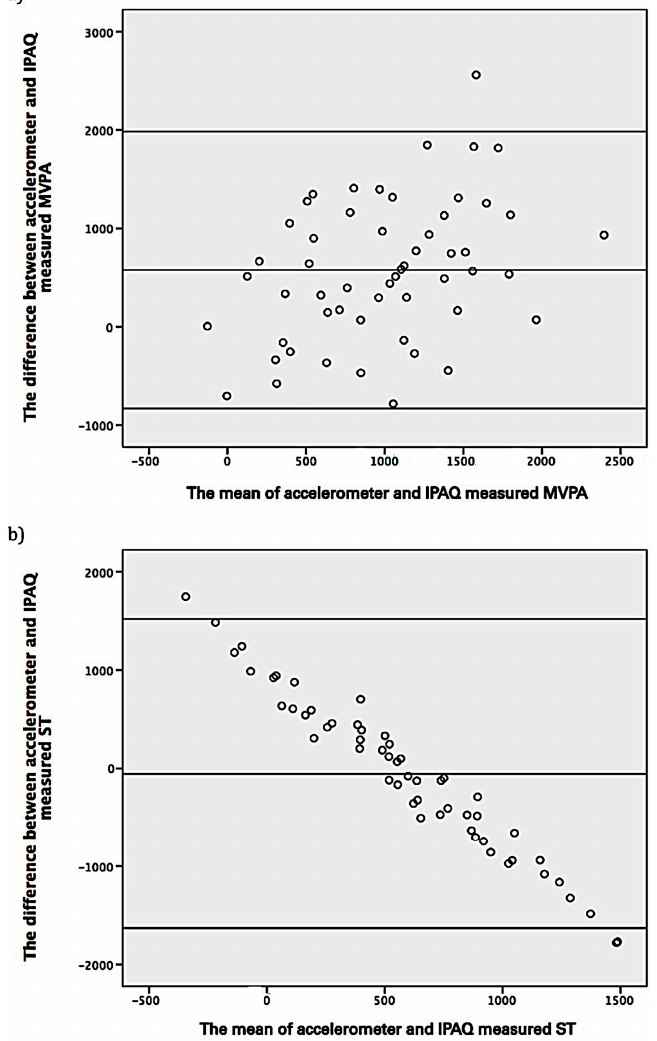
Figure 1. ( a ) The difference between accelerometer and IPAQ measured MVPA ( y -axis) plotted against the mean difference of accelerometer and IPAQ measured MVPA ( x -axis) with 95% limits of agreement. Overall mean difference was 578.2 MET–min/week and the limits of agreement were − 828.7 to 1985.1; ( b ) The difference between accelerometer and IPAQ measured ST ( y -axis) plotted against the mean difference of accelerometer and IPAQ measured ST ( x -axis) with 95% limits of agreement. Overall mean difference was − 56.2 MET–min/day and the limits of agreement were − 1631.2 to 1518.9. Data shown are normalised using the two-step